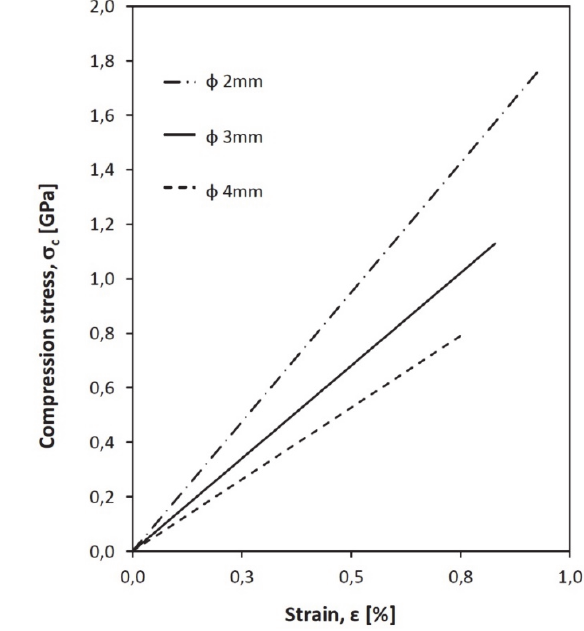
Figure 2: Compressive stress-strain curves of the Fe 36 Co 36 B 19 Si 5 Nb 4 BMGs rods with diameters of  =2,3 and 4 mm.